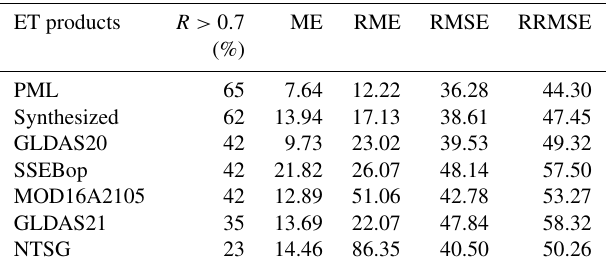
Table 14. Percentage of R more than 0.70 and the maximum abso- lute value of ME (mm), RME (%), RMSE (mm), and RRMSE (%) across all comparison levels (01–26) of the highly performing ET products and the synthesized